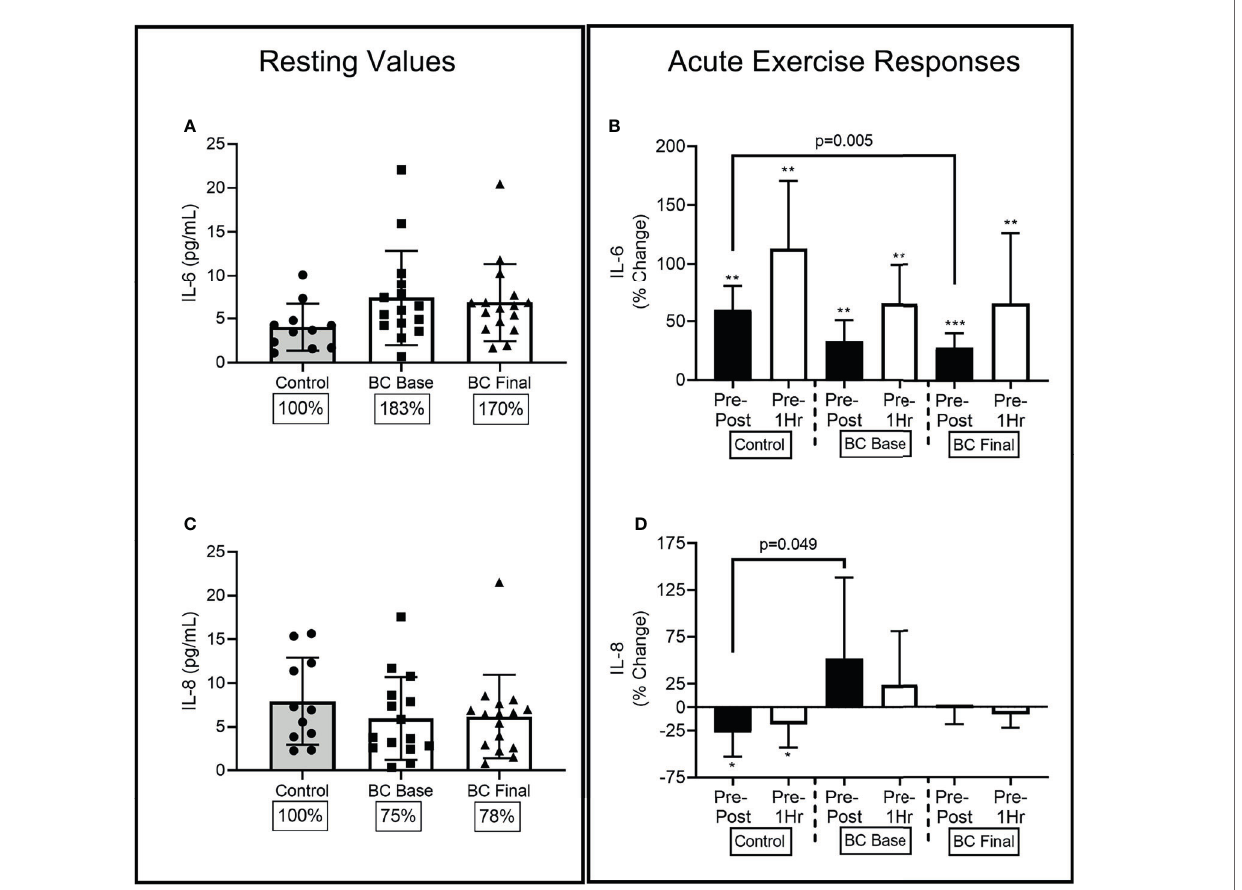
FIGURE 4 | Circulating serological IL-6 and IL-8 differences between Controls and BCS measured once in Controls, and before and after 16 weeks of exercise in BCS. Panels show, resting values (Left Panels), and acute exercise responses (Right Panels) for percentage changes pre exercise to immediately post exercise (Pre-Post), and Pre exercise to 1 hour after exercise completion (Pre-1Hr). Panels show IL-6 concentrations at rest (A) and during acute exercise (B) , and IL-8 concentrations at rest (C) and during acute exercise (D) , *p < 0.05, **p < 0.01 and ***p < 0.001 signi fi cant change for groups acute response. Where shown, the Controls mean values have been assigned 100% to represent the optimal response, and BCS the percentage of Control means. Data are mean